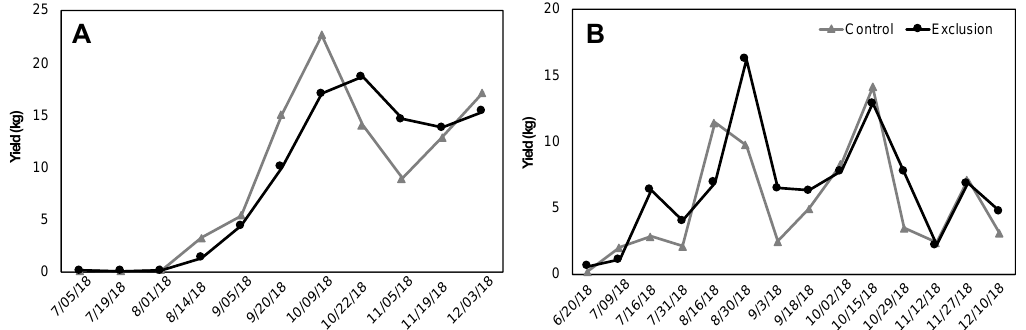
Figure 5. Total yield (kg) of ripe coffee fruit harvested from 20 trees per treatment (un-netted control and netted exclusion) on two Hawai’i Island farms: Farm 1 (279 m, var. catuai ) ( A ) and Farm 2 (393 m, var. typica ) ( B ).